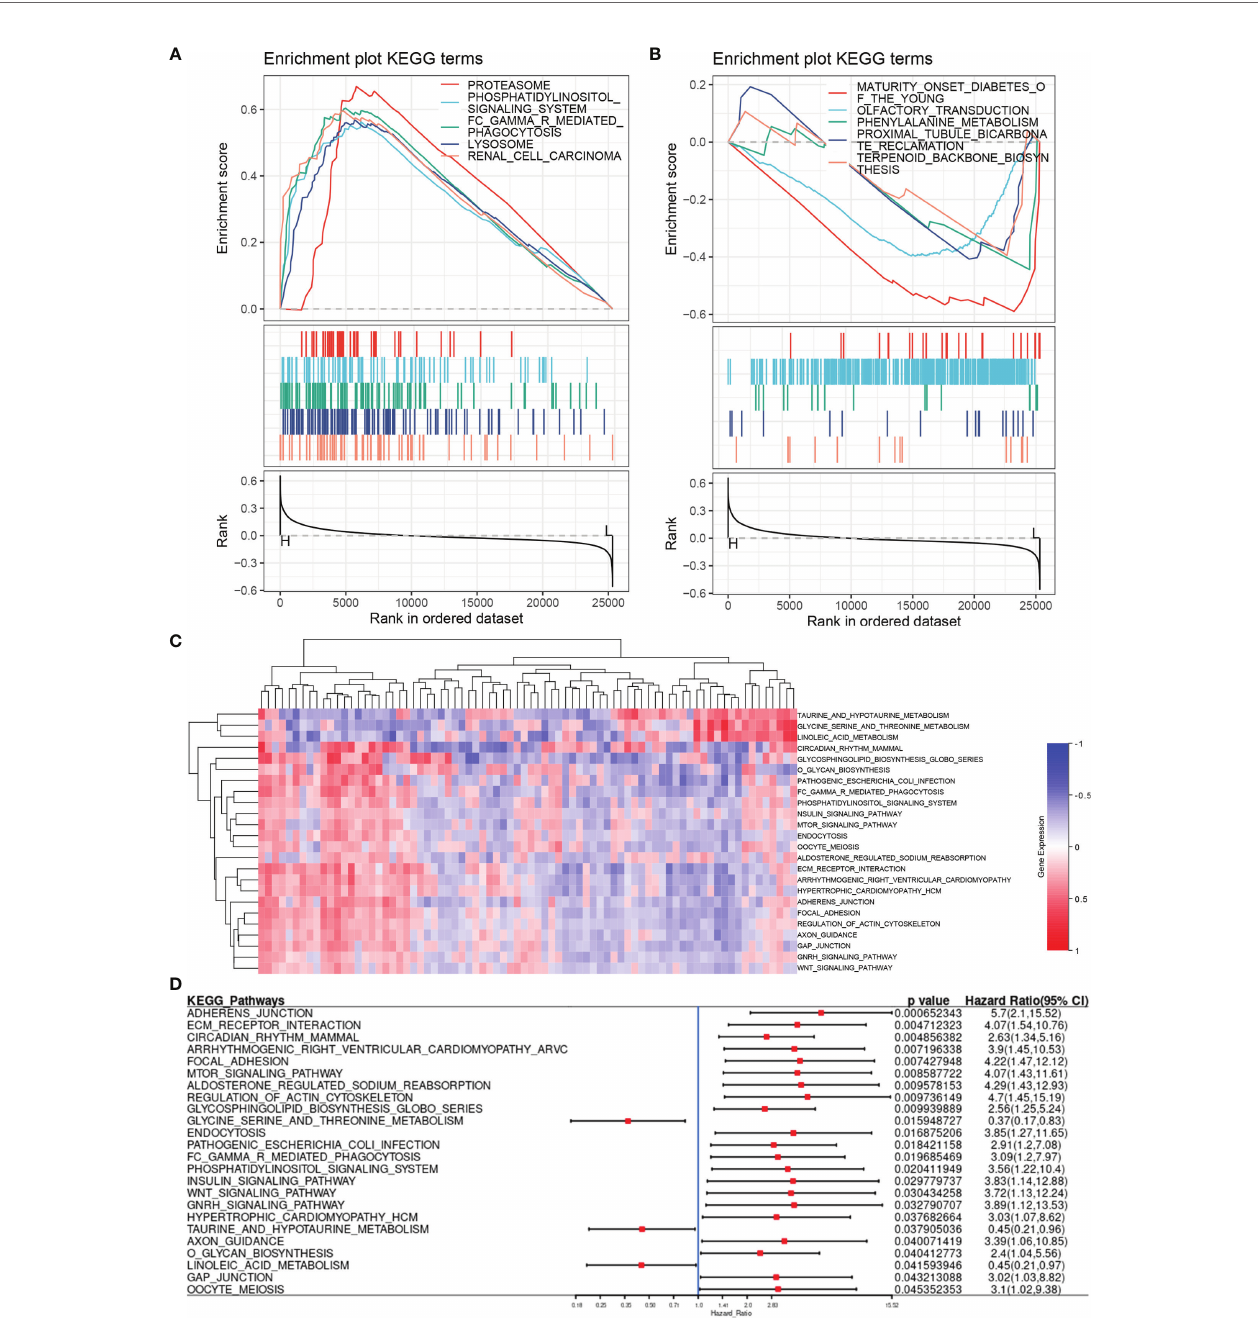
FIGURE 6 | Pathway enrichment analysis based on the Fer-score. (A, B) are the enrichment pathways that are positively and negatively correlated with the Fer-score according to GSEA. (C) Heat map of the pathway variation matrix (by GSVA). (D) Forest diagram displaying the results of the Cox analysis of the pathway variation